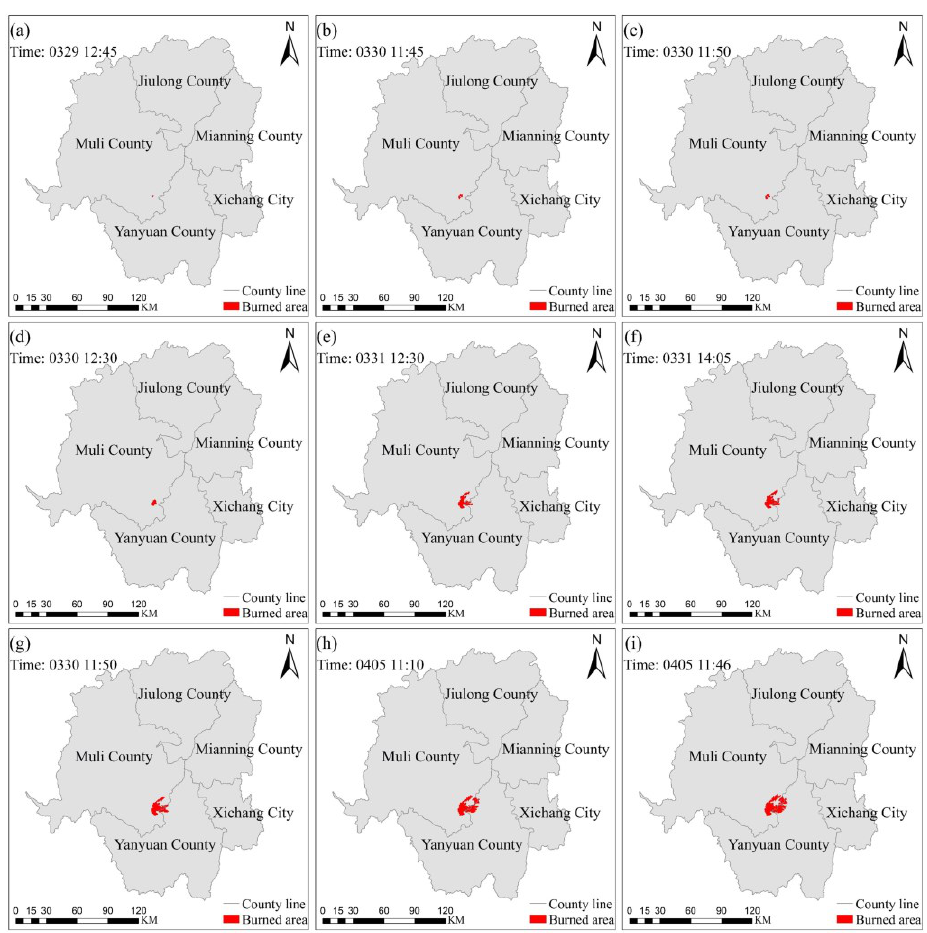
Figure 4. Multi-source satellite remote sensing image extraction of the burned area in Muli County.